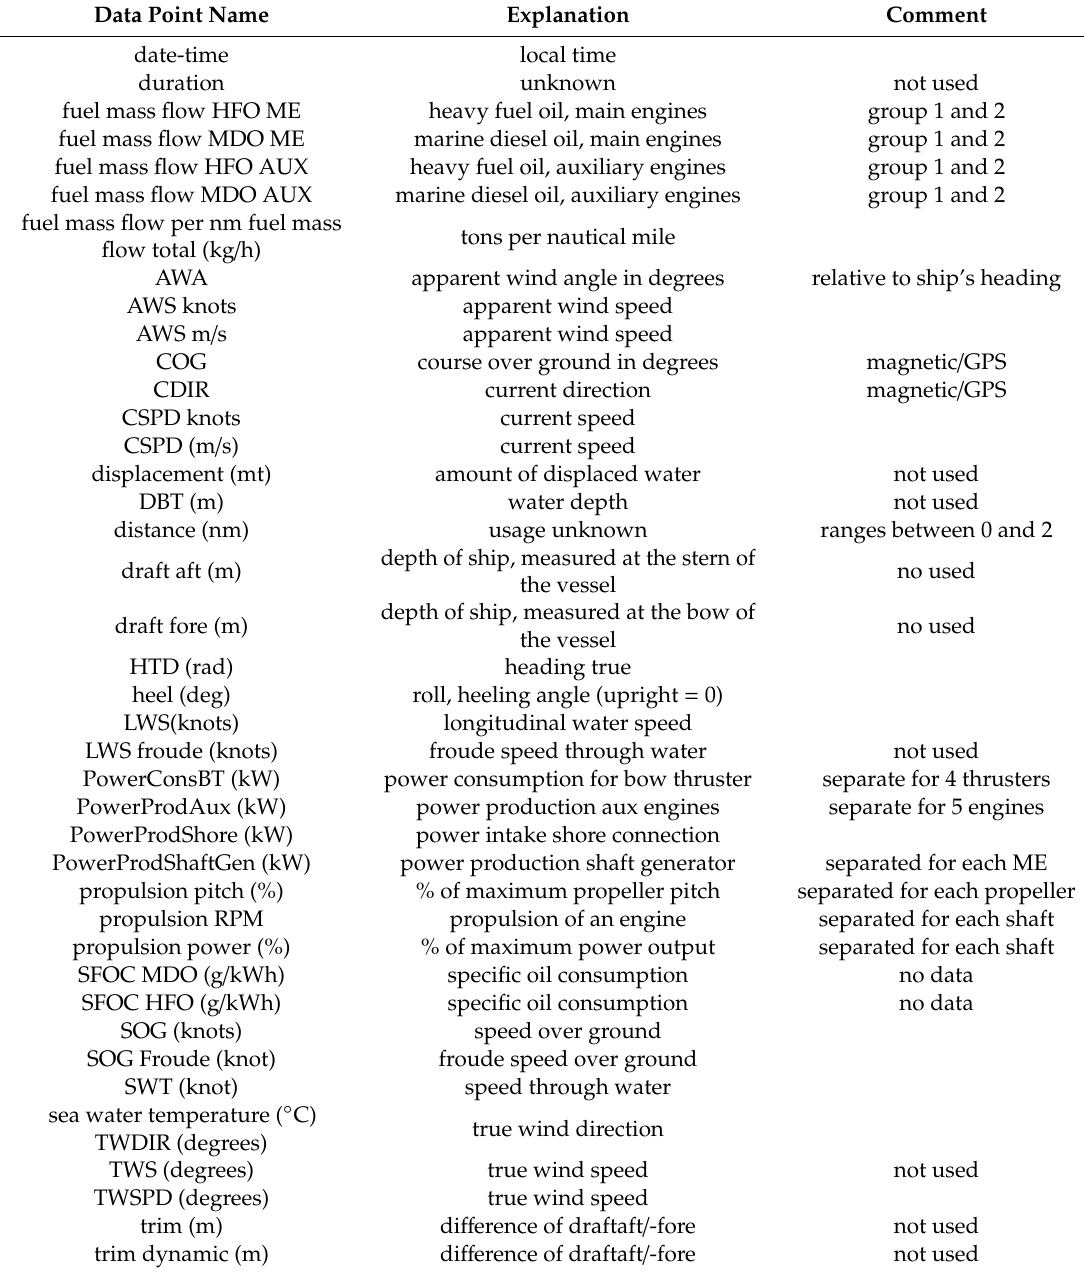
Table A1. Measurements of on-board ship